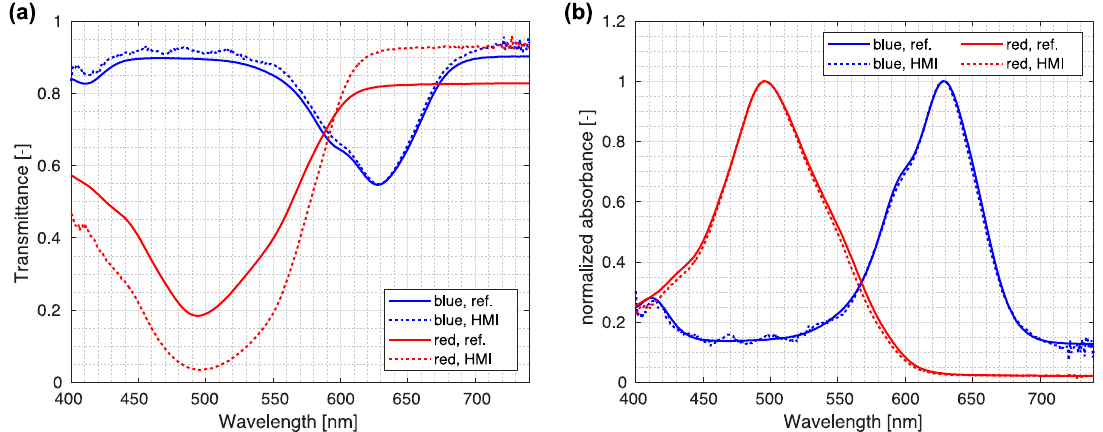
Figure 6. Comparison between spectra measured by HMI and reference spectra. ( a ) Comparison of raw normalized spectra acquired using the reference spectrometer and custom-made HMI system. ( b ) Normalized absorbance from reference and HMI measured spectra.